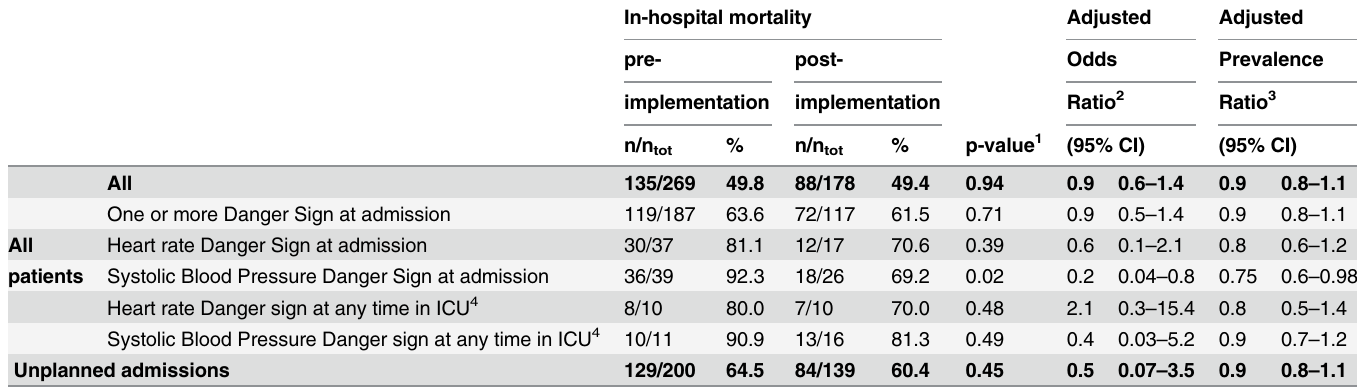
Table 3. In-hospital mortality. In-hospital mortality in pre and post-implementation patients, by the presence of danger